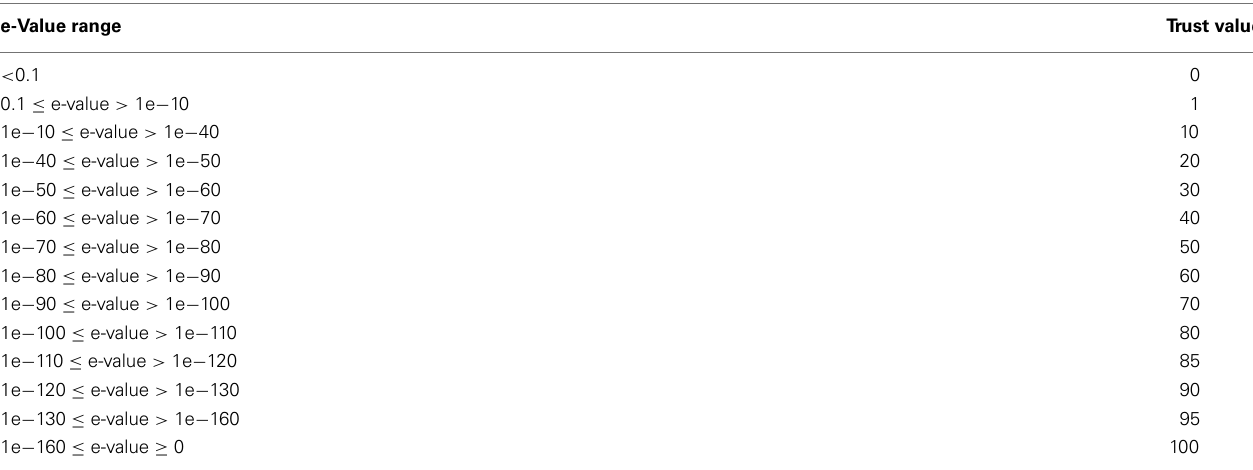
TableA1 | e-Value range based trust